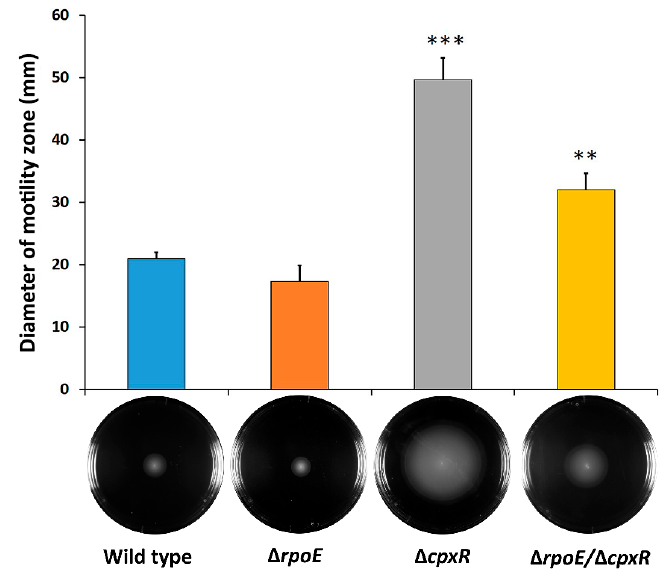
Figure 2. E ff ect of deletion of the rpoE, cpxR and rpoE / cpxR genes on the swarming motility, as determined by swimming distance (diameter in mm) of cells in motility agar. Quantification of swarm ring diameter of the wild-type and the isogenic ∆ rpoE, ∆ cpxR and ∆ rpoE / cpxR mutant strains was performed after 24 h of incubation at room temperature. Each data point represents the average of at least three independent experiments. Error bars represent the standard deviation as determined by t-test in comparison to the wild-type strain. ** p < 0.01, *** p < 0.001. In contrast to the Δ rpoE strain, the Δ cpxR mutant exhibited more than two times increased swarming (50 mm in diameter) compared to the wild type, while the double Δ rpoE / Δ cpxR mutant showed a reduced motility trend (32 mm in diameter) compared to the Δ cpxR, but increased motility relative to the wild-type strain (Figure 2). Deletion of the cpxR gene resulted in a highly-significant ( p < 0.001) increase in swarming motility of S . Enteritidis; whereas, the rpoE deletion did not significantly ( p = 0.3) affect motility of the same organism (Figure 2). We subsequently sought to determine the effect of single gene deletions ( rpoE and cpxR ), as well as the effect of the double rpoE / cpxR deletion, on the ability of S . Enteritidis cells to auto-aggregate. Among these four organisms, the wild-type exhibited the greatest ability to auto-aggregate (80%), followed by the Δ rpoE mutant (60%) (Figure 3A,B).